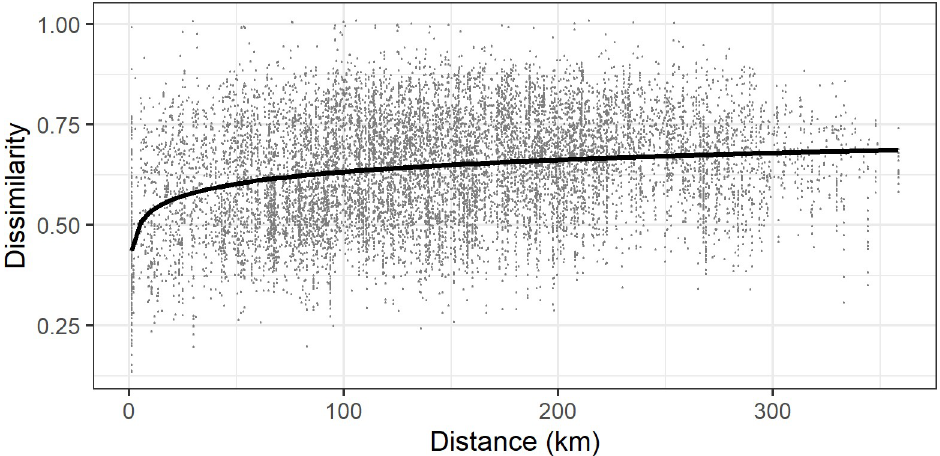
Fig 3. Geographical distance and dissimilarity between speakers (central tendency by logarithmic curve).